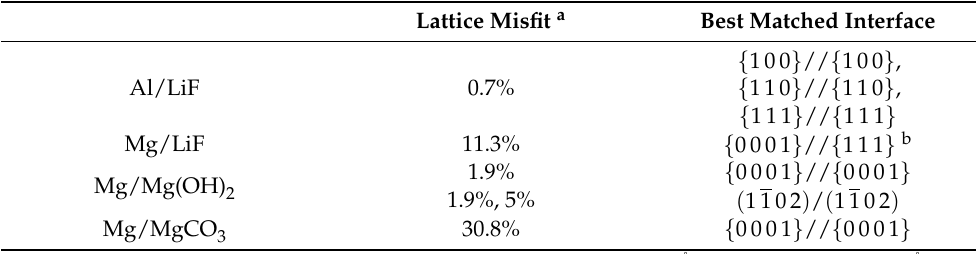
Table 2. Lattice constant comparisons for low index planes.